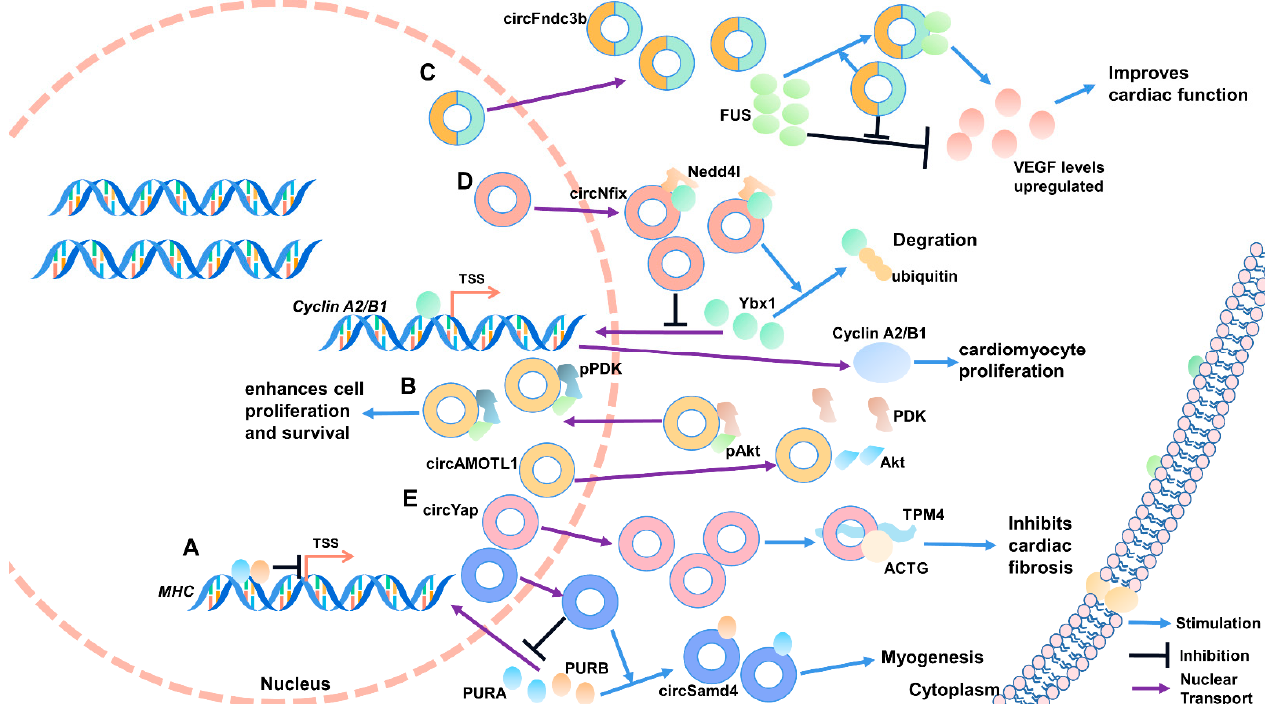
Figure 3. CircRNA–protein interactions regulating muscle development and diseases. ( A ) PURA and PURB inhibit the transcription of MHC , and circsamd4 promotes myogenesis by binding PURA and PURB. ( B ) circAMOTL1 induces AKT1 phosphorylation and pAKT1 nuclear transport by combining AKT1 and PDK1. ( C ) FUS negatively regulates VEGF-A expression, and circFndc3b promotes VEGF-A expression by binding to FUS. ( D ) circNFIX acts as a protein scaffold to enhance the binding of Ybx1 and Nedd41, induce ubiquitination degradation of Ybx1, and inhibit cyclin A2 and cyclin B1. ( E ) circYAP can inhibit cardiac fibrosis by acting as a protein scaffold to promote TMP4 and ACTG complexes’ formation. TSS: transcription start site.